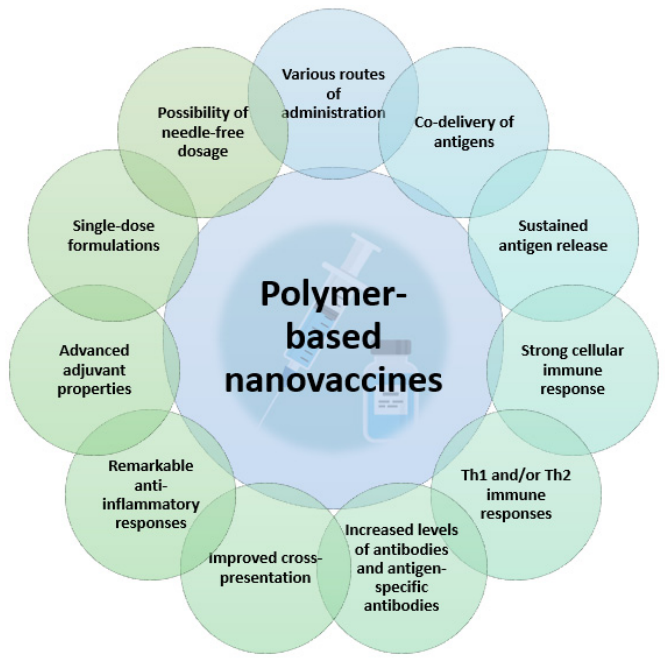
Figure 7. Advantages of polymer-based nanovaccines. Created based on information from literature references [11,18,154,284].